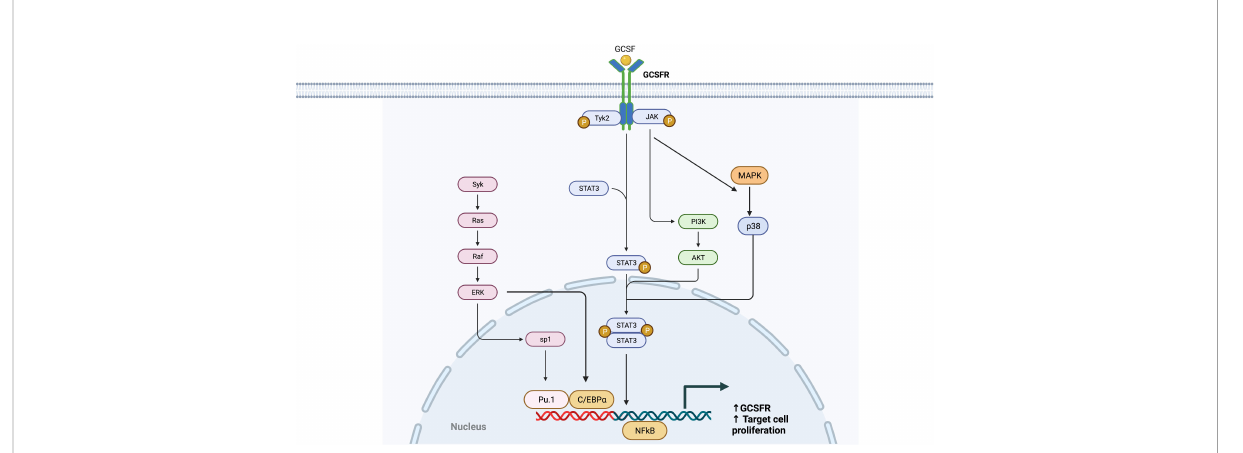
FIGURE 5 Transcription Factors of GCSFR (CSF3R). Adapted from “ CREB Signaling Pathway ” , by BioRender.com (2022). Retrieved from https://app.